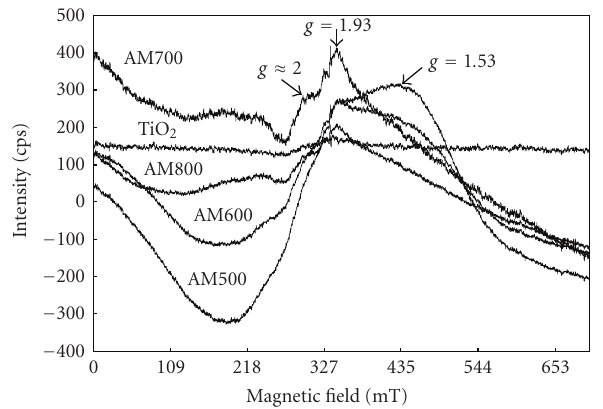
Figure 19: EPR spectra of TiO 2 and Fe-C-TiO 2 samples prepared from anatase and Fe-C 2 O 4 at 500–800 ◦